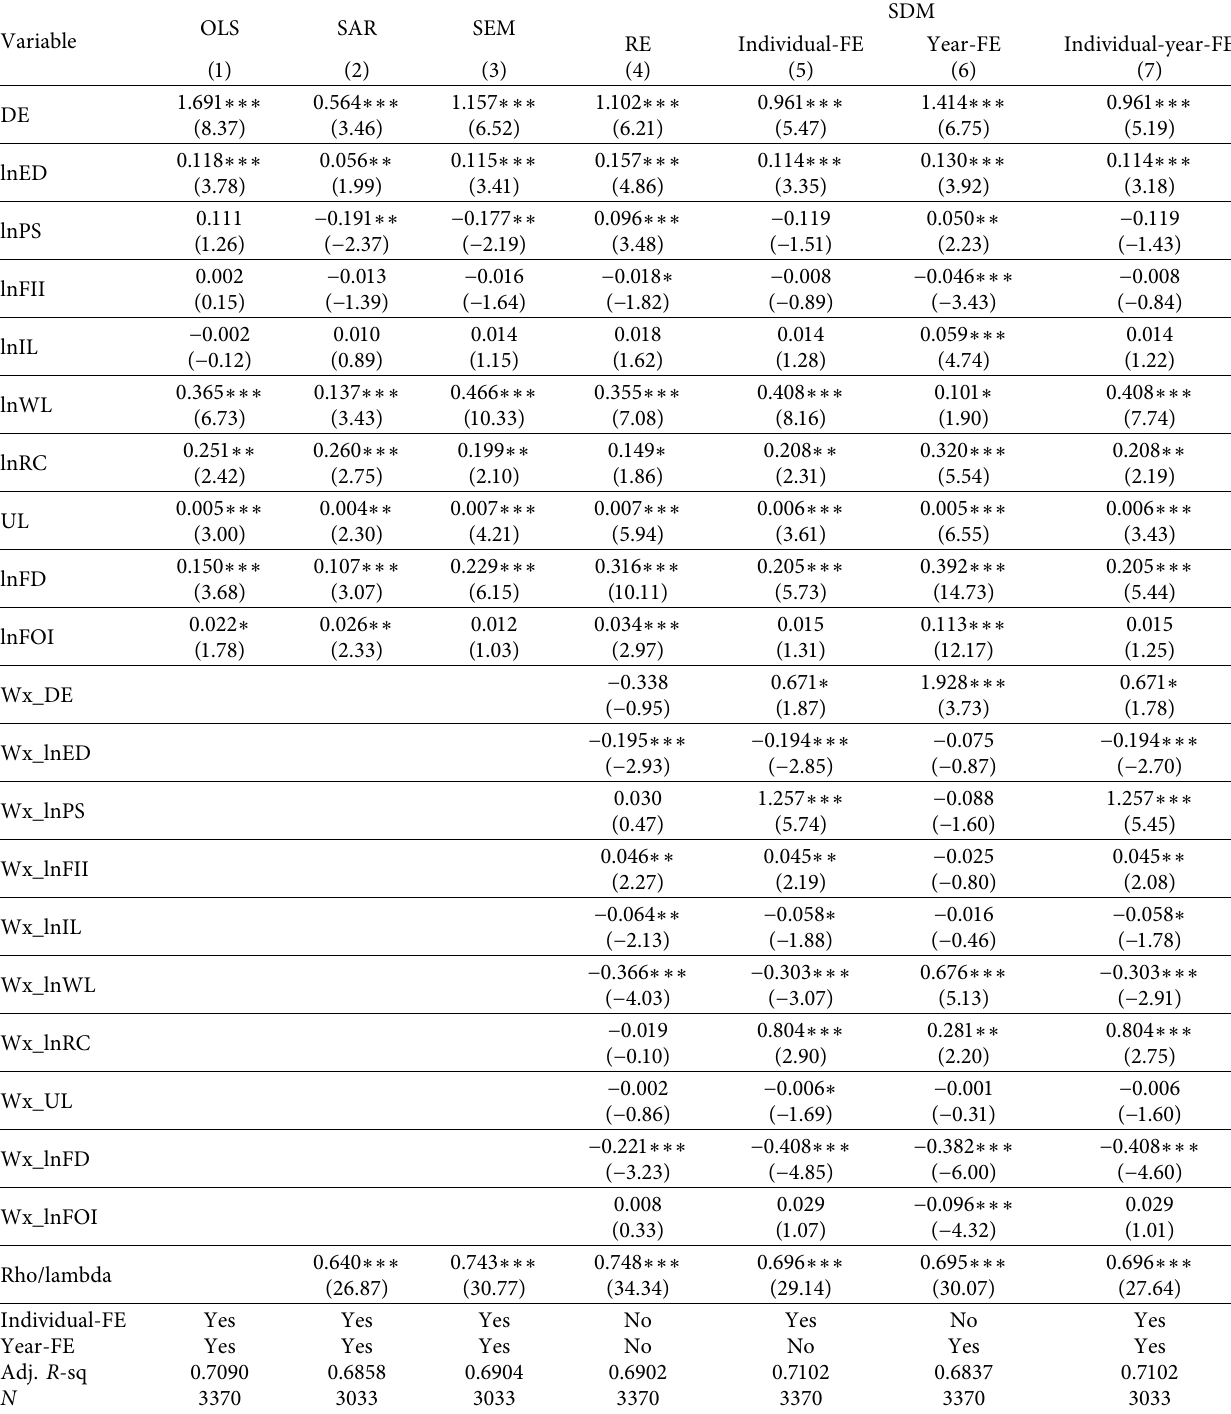
Table 3: Results of spatial econometric analysis for impact of the digital economy on urban economy.